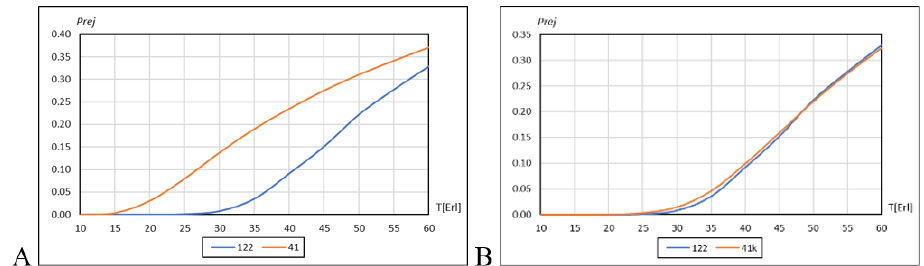
Figure 6. Results of simulations for graph 41 compared to graph 122: ( A ) without the correction procedure; ( B ) with the correction